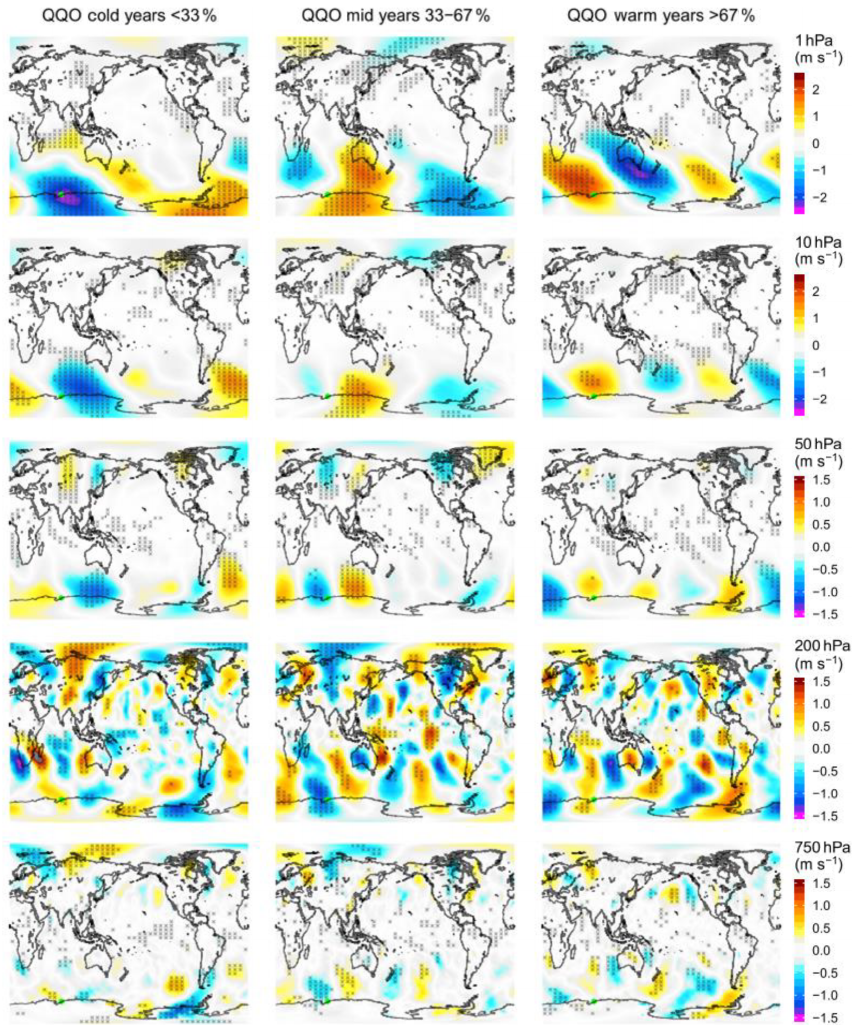
Figure 4. Composites of the ERA5 (AMJJAS) meridional wind anomaly, for cold, mid, and warm years of the Davis detrended winter average QQO signal. Pressure levels are indicated on the right-hand colour bar. The colour scales are in metres per second. Hashed areas on the plots are significant at the 90% level. Zonal wind anomaly equivalent in Fig. S3